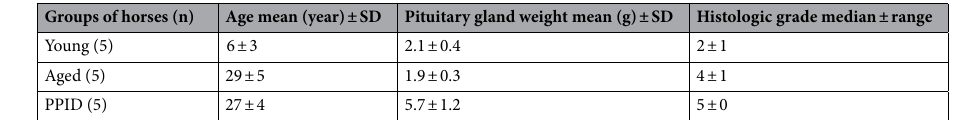
Table 1. Mean age and pituitary gland weights and histologic grades for each group of horses.